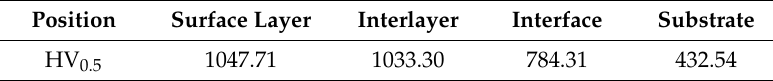
Figure 7. Interfacial indentation at a load of 500 g.